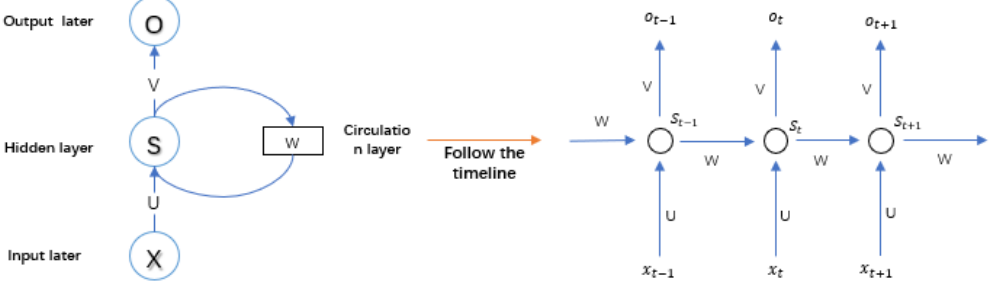
Figure 3. RNN timeline expansion diagram.